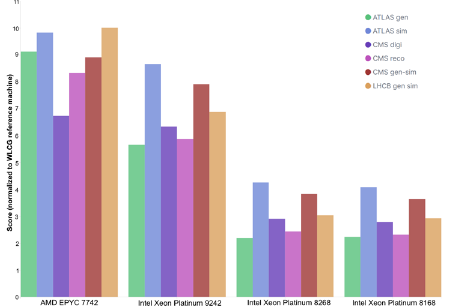
Figure 6: Experiment workload